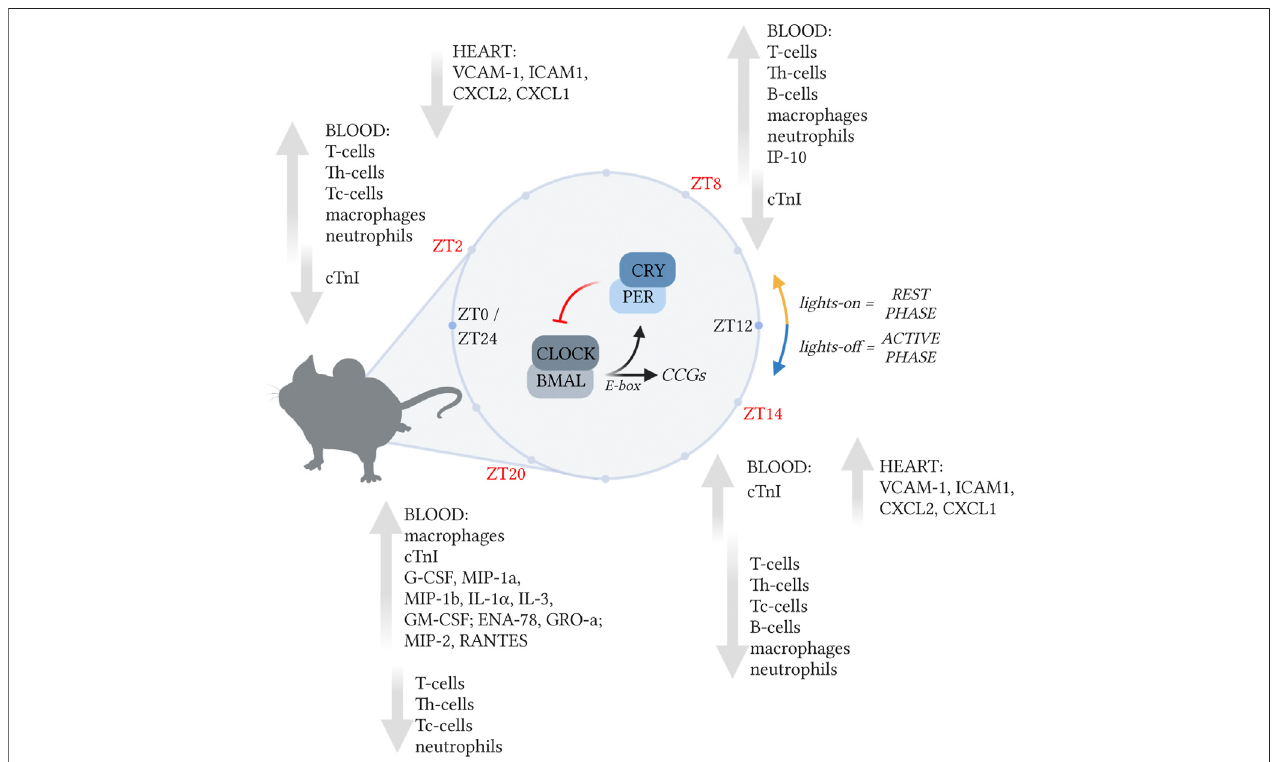
FIGURE7| Theimmuneresponsepost-MIisregulatedinacircadian-dependent manner.Theimmuneresponseinthepost-MIheartvariesdependingonthetime ofdayMIoccurred.Intheblood, leukocytenumberspeakedduringtherest-phase(ZT2andZT8),whenchemokineandcytokinelevelswerelow.Neutrophil-associated chemokines and cytokinesreachedtheirhighestlevelsduring theactive-phase(ZT14).In theheart, theexpression ofchemokine and adhesion molecules ( Cxcl1 , Cxcl2 , Vcam1, and Icam1 ), was maximum when MI was induced during the active-phase (ZT14). Created with BioRender.com.